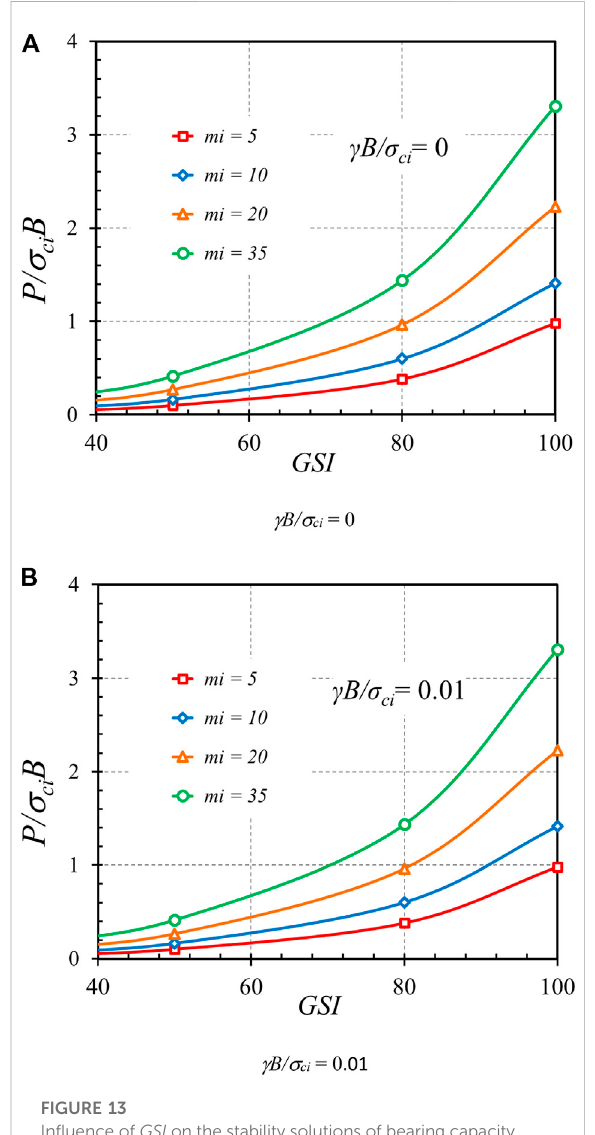
FIGURE 13 In fl uence of GSI on the stability solutions of bearing capacity factor on the rock mass ( β = 45 ° , e/B = 0, and α = 1). (A) γ B/ σ ci = 0 (B) γ B/ σ ci = 0.01.